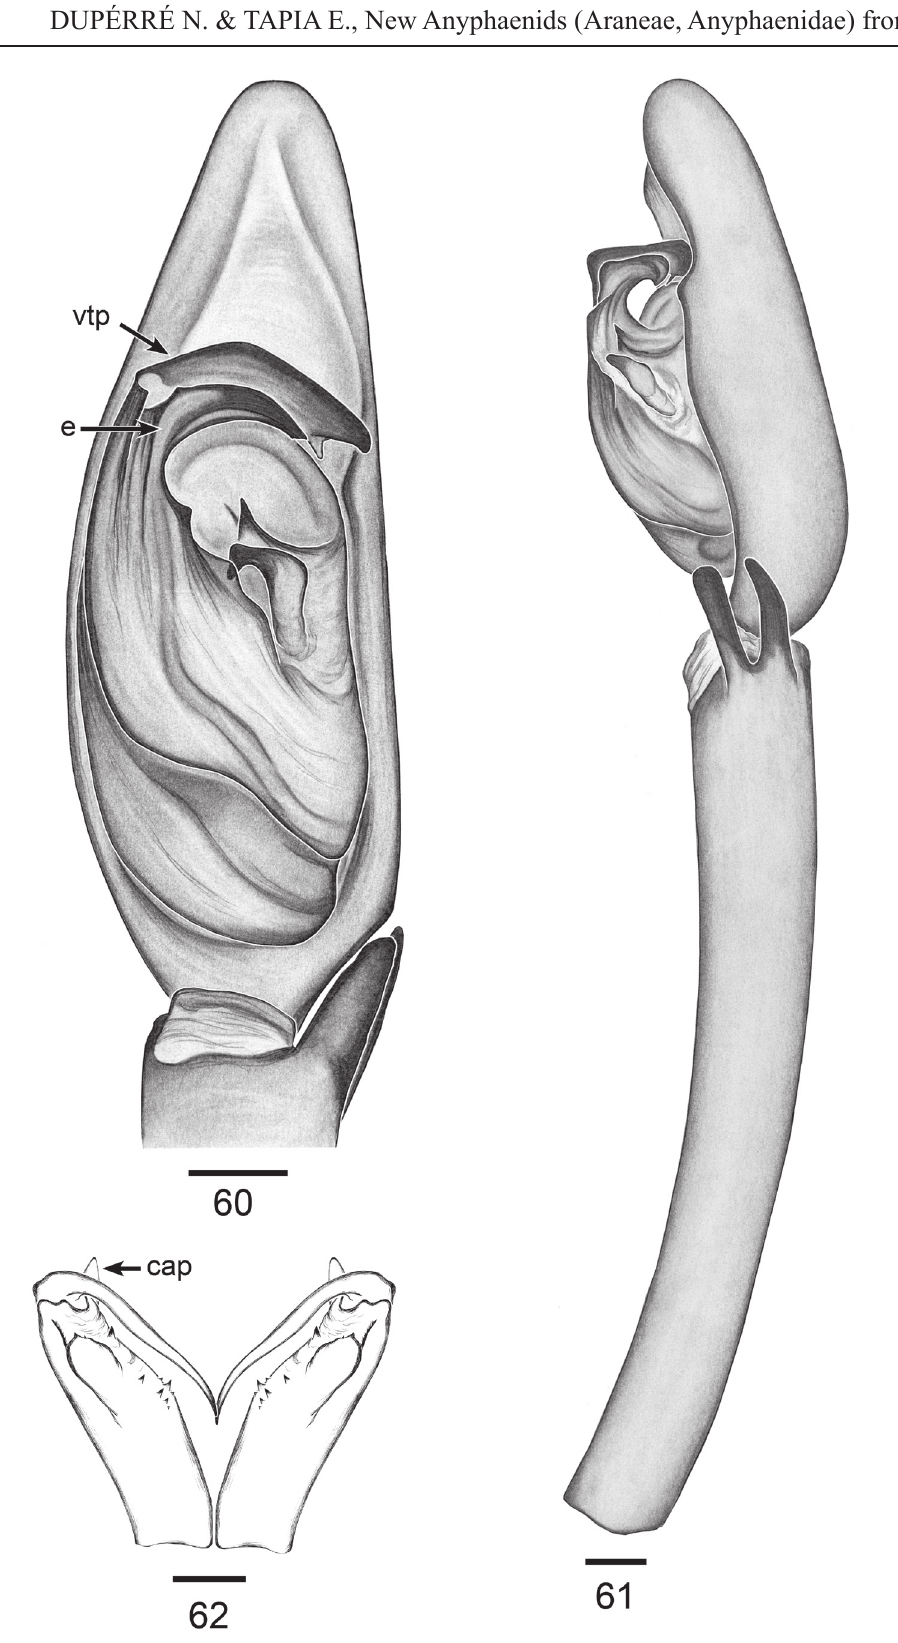
Figs 60–62. Patrera suni sp. nov. 60 . ♂, palp, ventral view. 61 . ♂, palp, retrolateral view. 62 . ♂, chelicerae, posterior view. Scale bars: 60–61 = 0.1 mm; 62 = 0.5